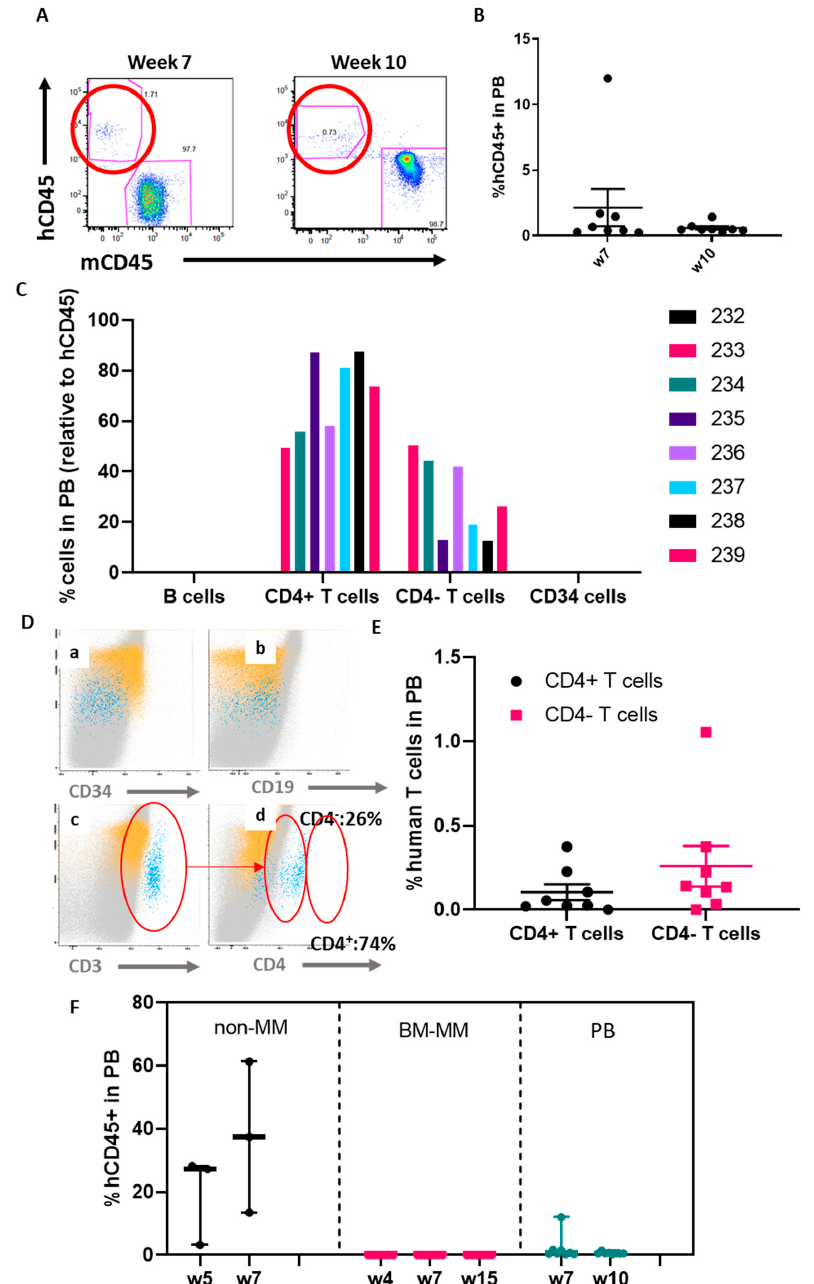
Figure 7. A high dose (120,000 cells) of MM patient-derived CD34 + cells is necessary for them to engraft in the construct. In total, 120,000 CD34 + cells were implanted in the inner scaffold and FACS was used to monitor its engraftment by detecting hCD45 + cells in peripheral blood. At week 7, some engraftment (average of 2%) was detected in peripheral blood ( A ). The engraftment decreased in week 10 in some of the mice ( A – B ). Most of the human cells detected were T cells ( C ). Gating strategy for detecting human T cell levels in peripheral blood ( D ). Human T cells were detected in peripheral